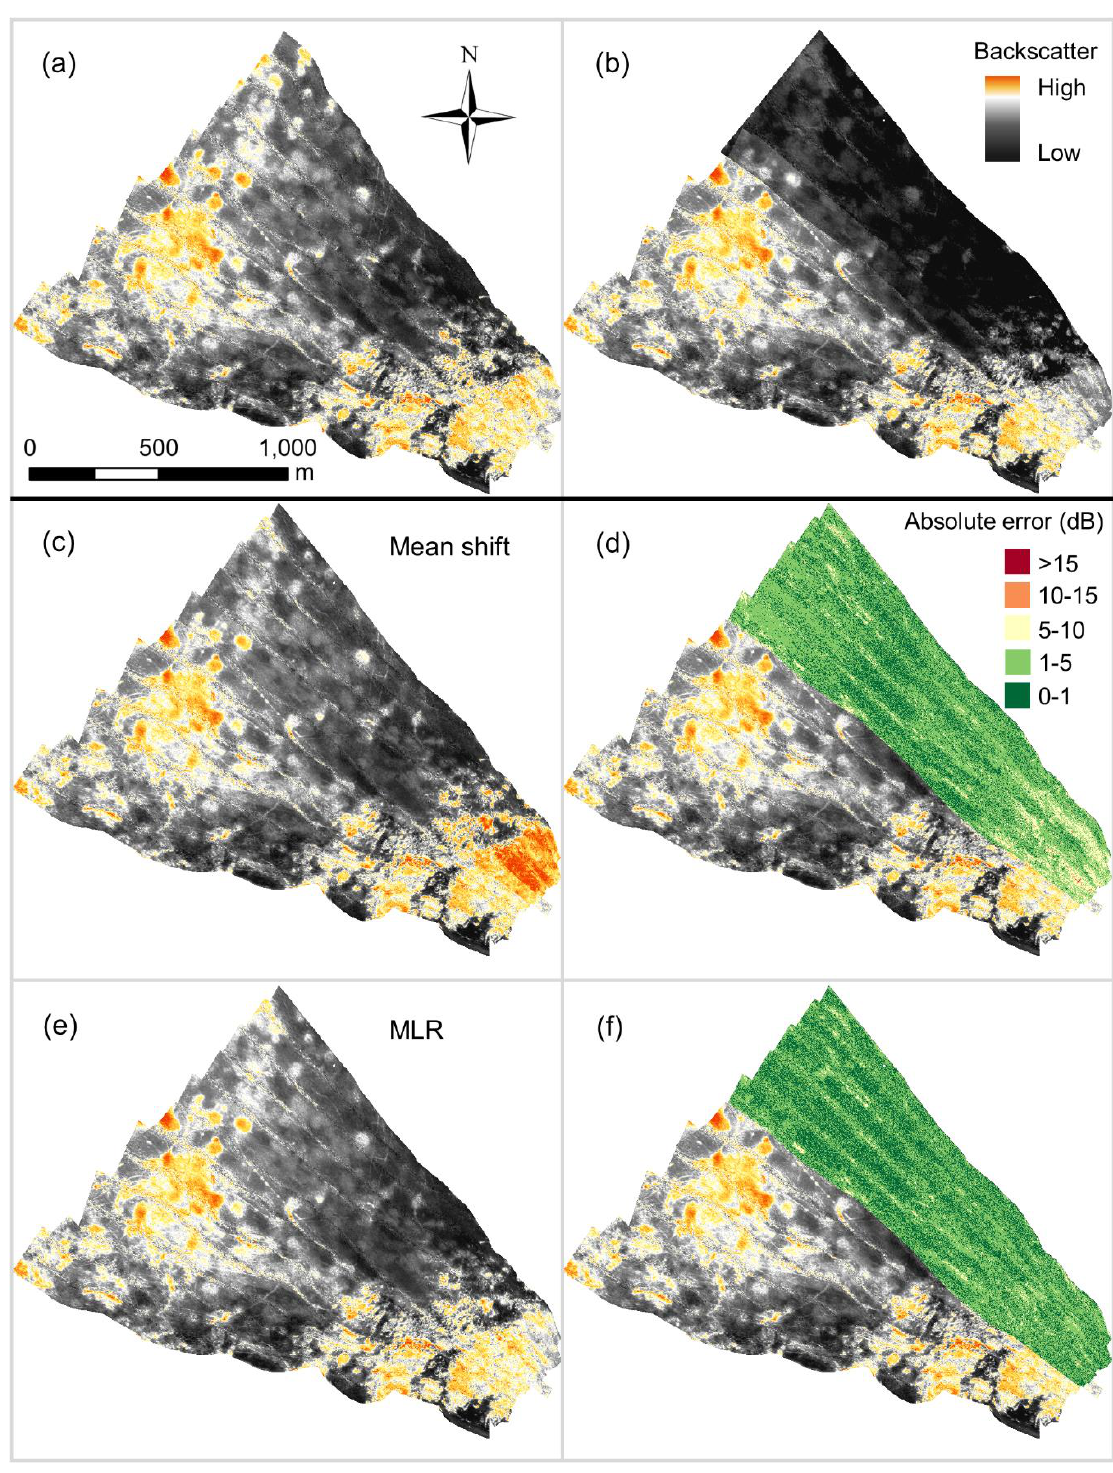
Figure 7. ( a ) Target 2016 100 kHz Bedford Basin backscatter dataset, ( b ) uncorrected mosaic with 2017 100 kHz data, ( c ) mean-shifted backscatter mosaic, ( d ) spatial distribution of mean-shifted backscatter error, ( e ) MLR-shifted mosaic, and ( f ) spatial distribution of MLR-shifted backscatter error.